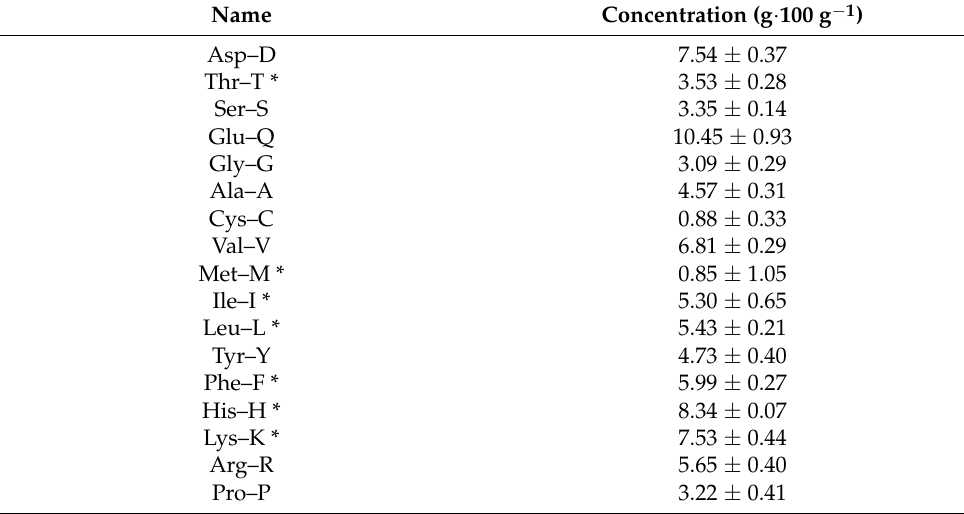
Table 3. Amino acid profile of the Spirulina-derived protein isolate. Results are expressed as g of amino acid per 100 g of